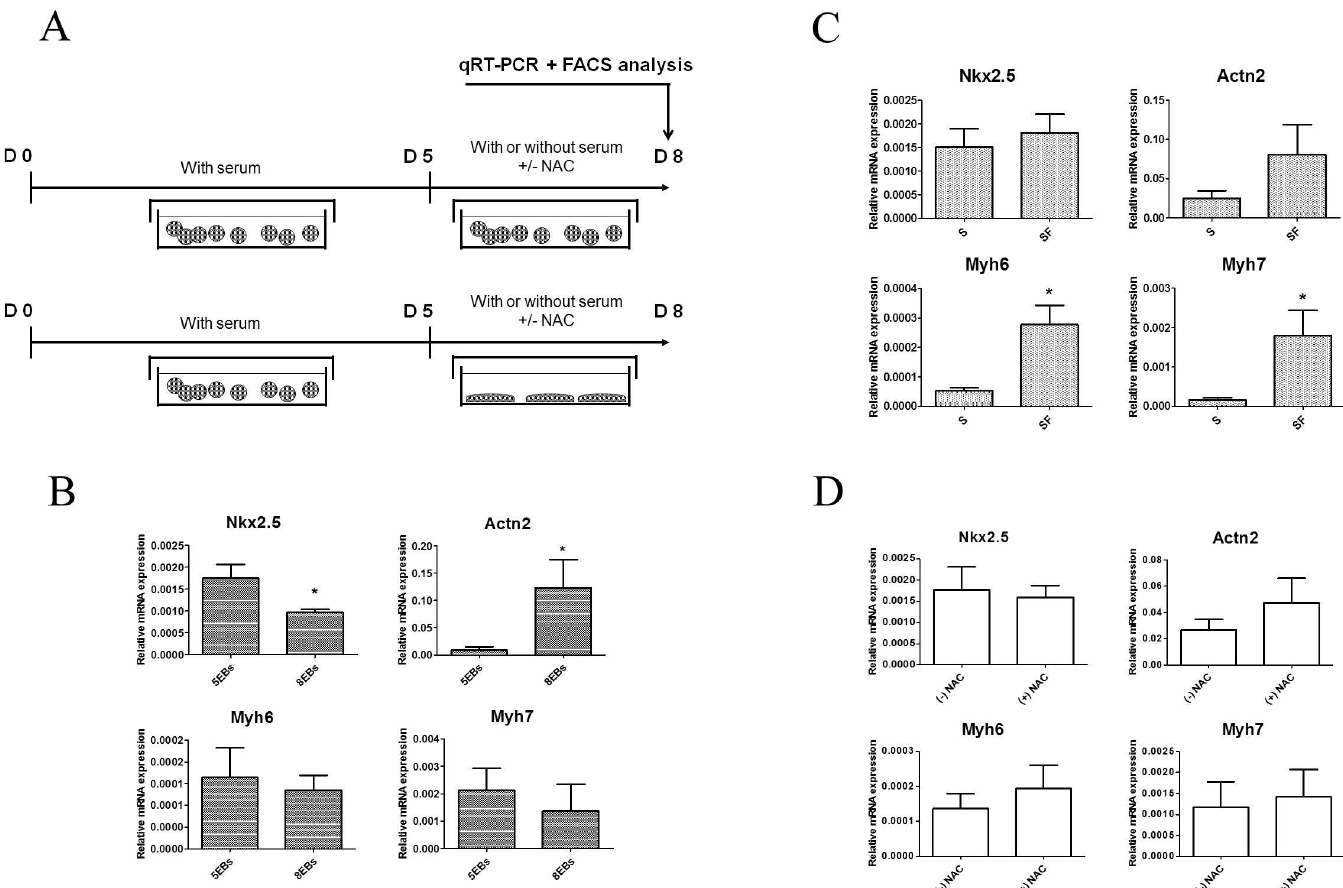
Fig 6. The experimental setup employed for comparison of the effectsof adhesion, FBS supplementation, and NAC supplementation analyzed by determination of the expression of cardiomyogenic markers at the end of the differentiation experiment (8 days). Supplementation was altered for the last 3 days of cultivationunder adherentor non-adherent conditions for EBs cultivation,after 5 days of cultivationin the form of EBs in the presence of FBS (A). Gene expressions of transcriptional factor Nkx2.5, Actn2, Myh6, and Myh7, recognized as markers of cardiomyocyte differentiation–data are presented as the effect of individualvariables: the adhesionof EBs on days 5 or 8 of differentiation(B), the presence(S) or absence(SF) of FBS (C), and the presence((+)NAC) or absence((-)NAC) of N-Acetyl Cysteine(D). Data are expressedas mean ± SEM (n = 4). Differencesbetweensamples were analyzed by Kruskal-Wallis test and post-hoc Dunns test and considered statisticallysignificantfor p (cid:20) 0.05; they are marked with asterisks.